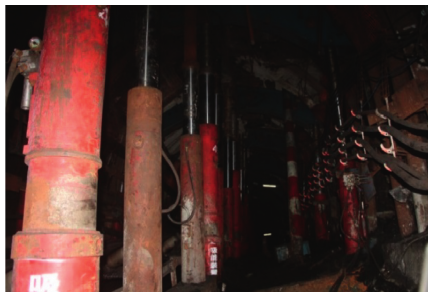
Figure 2: Field application drawing of energy absorbing support in the Gengcun mine, Henan Province, China.